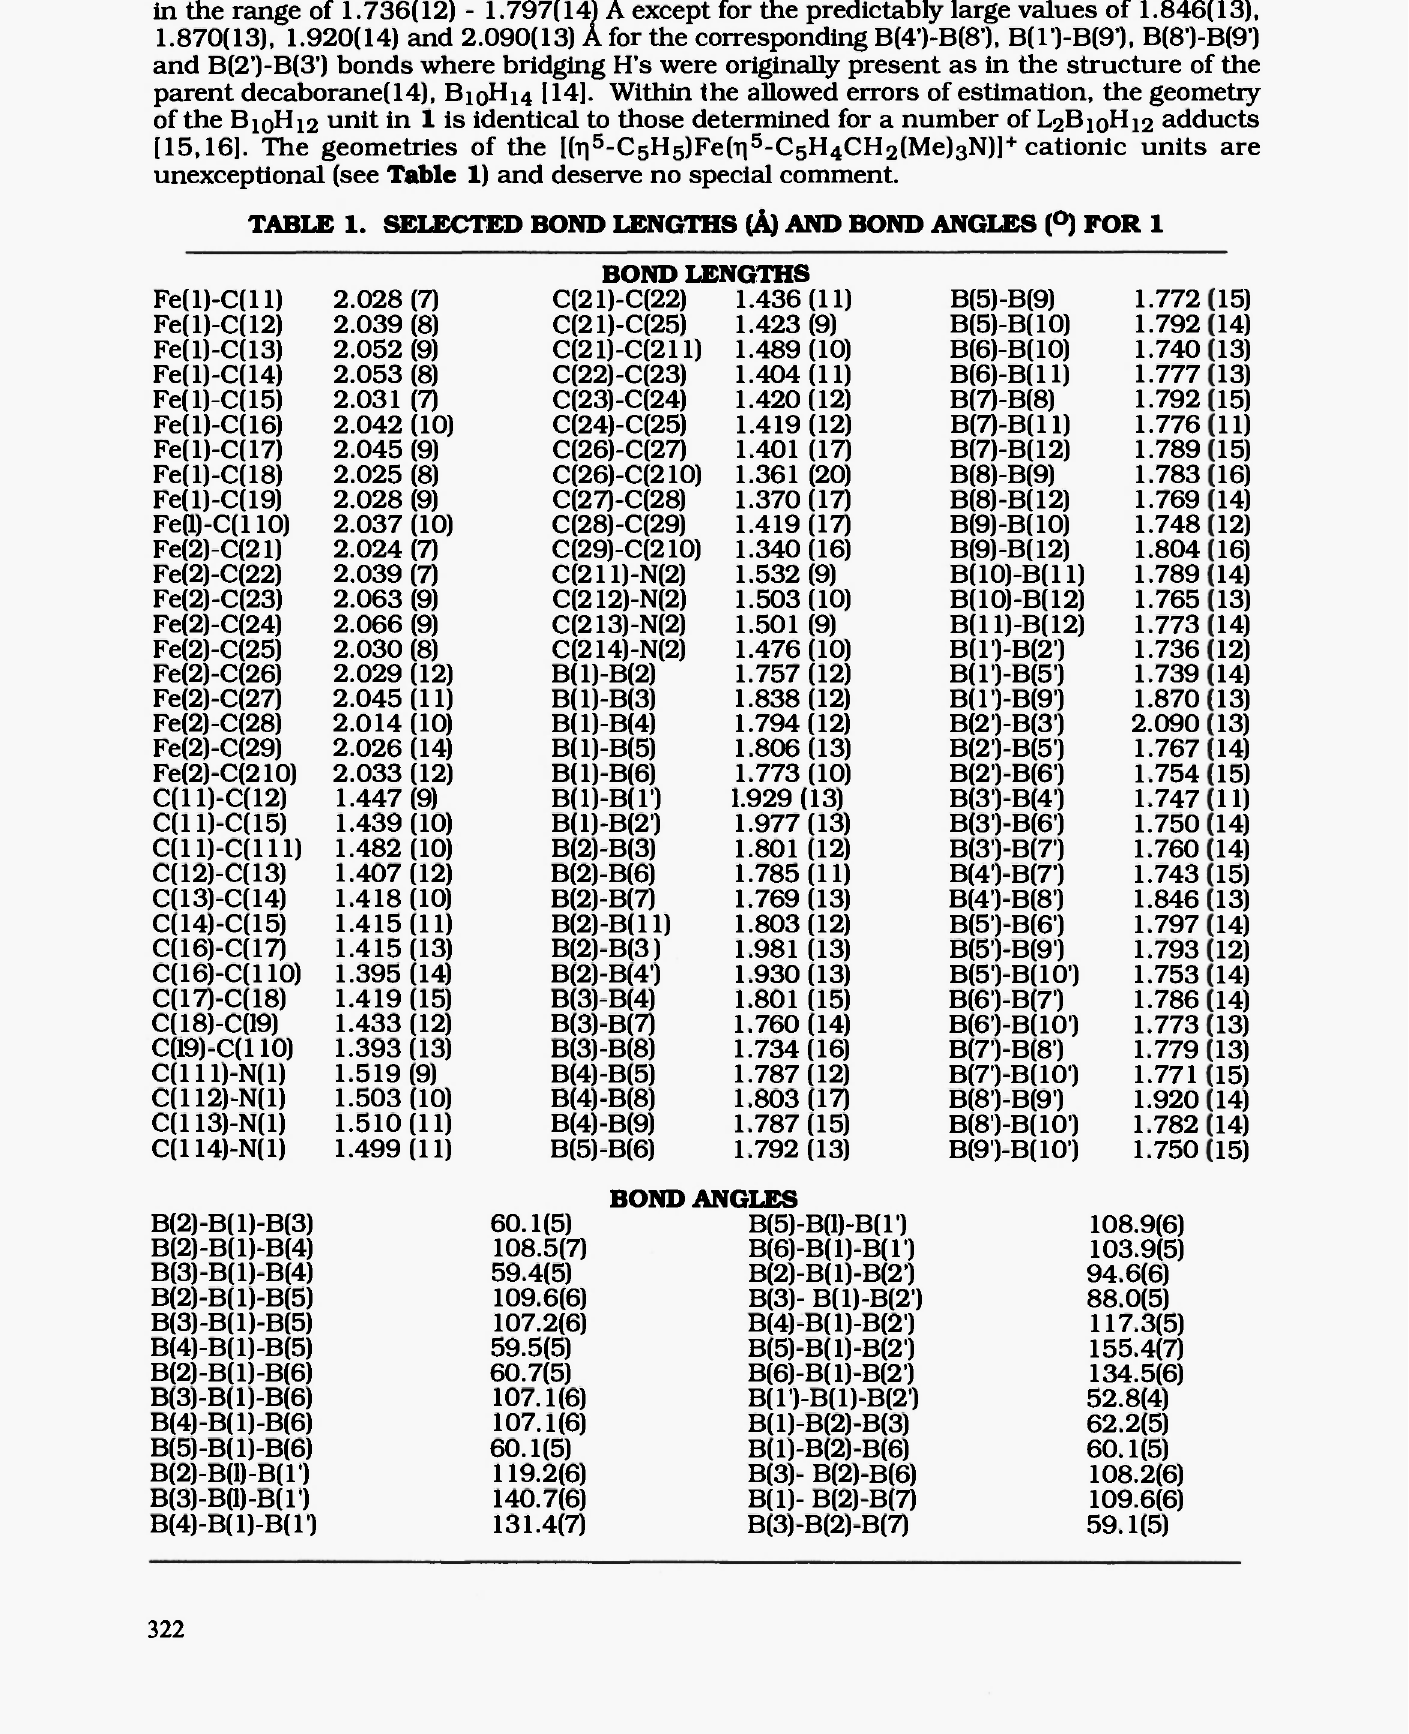
TABLE 1. SELECTED BOND LENGTHS (A) AND BOND ANGLES (°) FOR